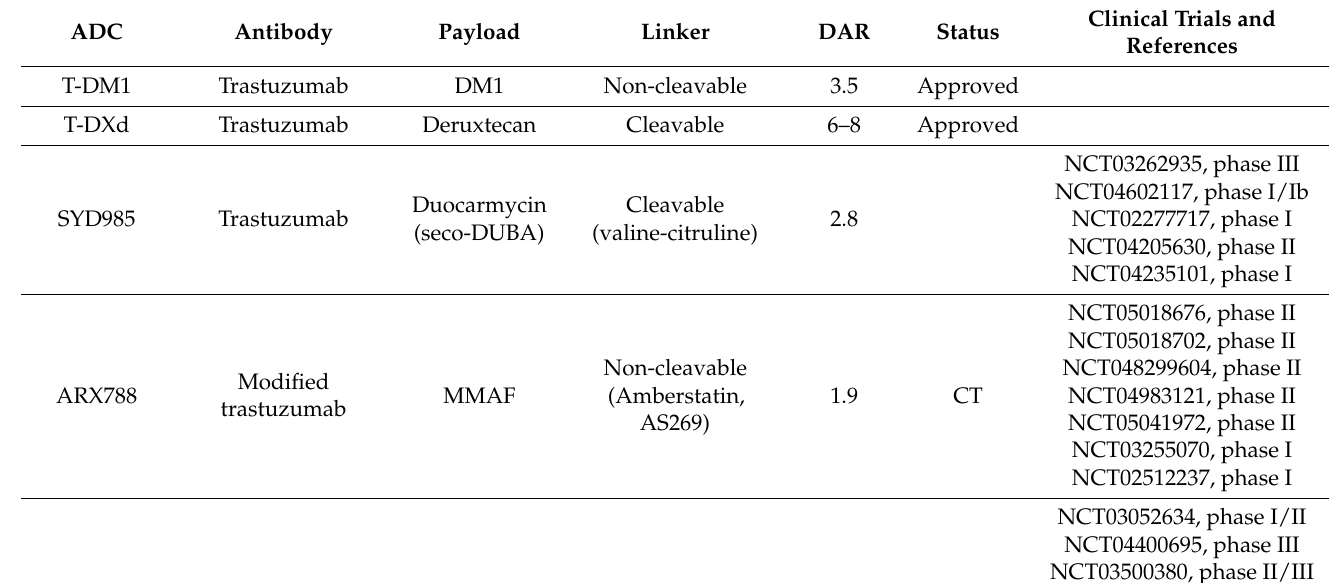
Table 1. Anti-HER2 ADCs approved for use or in clinical development (in clinical